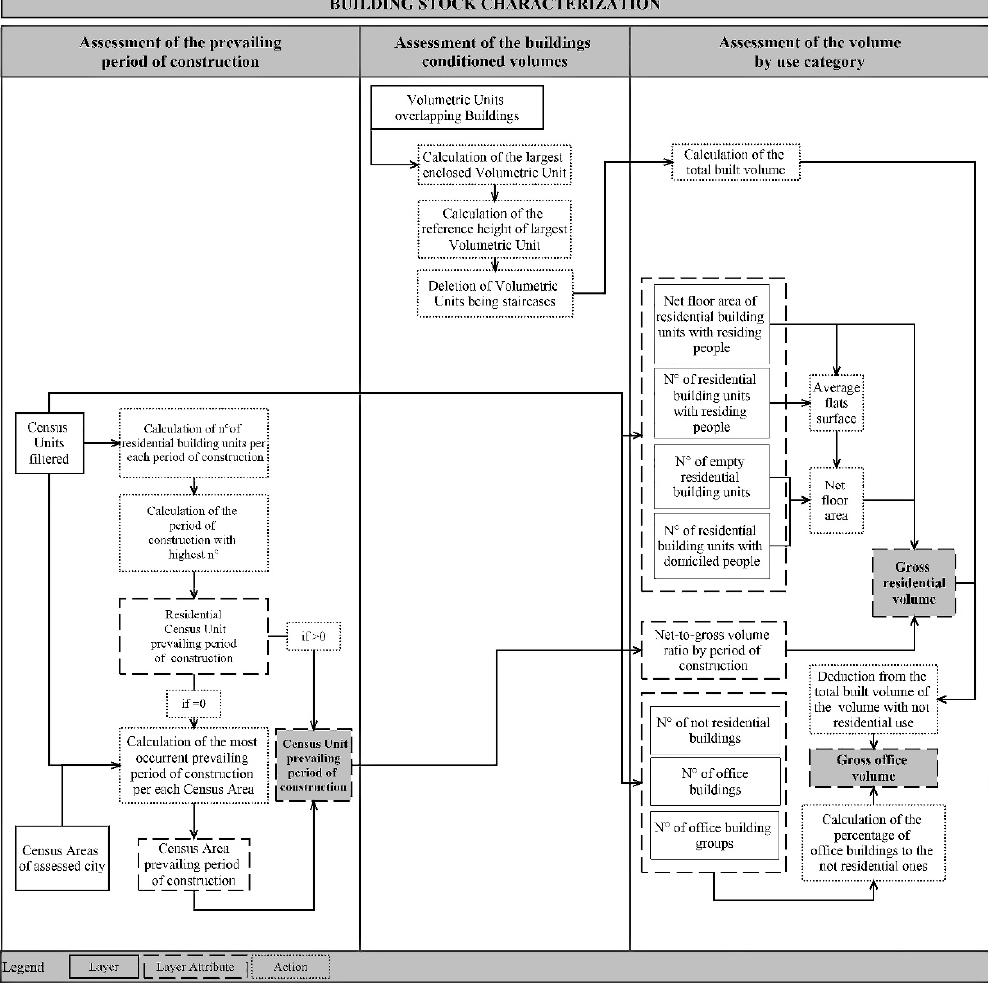
Figure 4. Flowchart of the building stock characterization procedure.